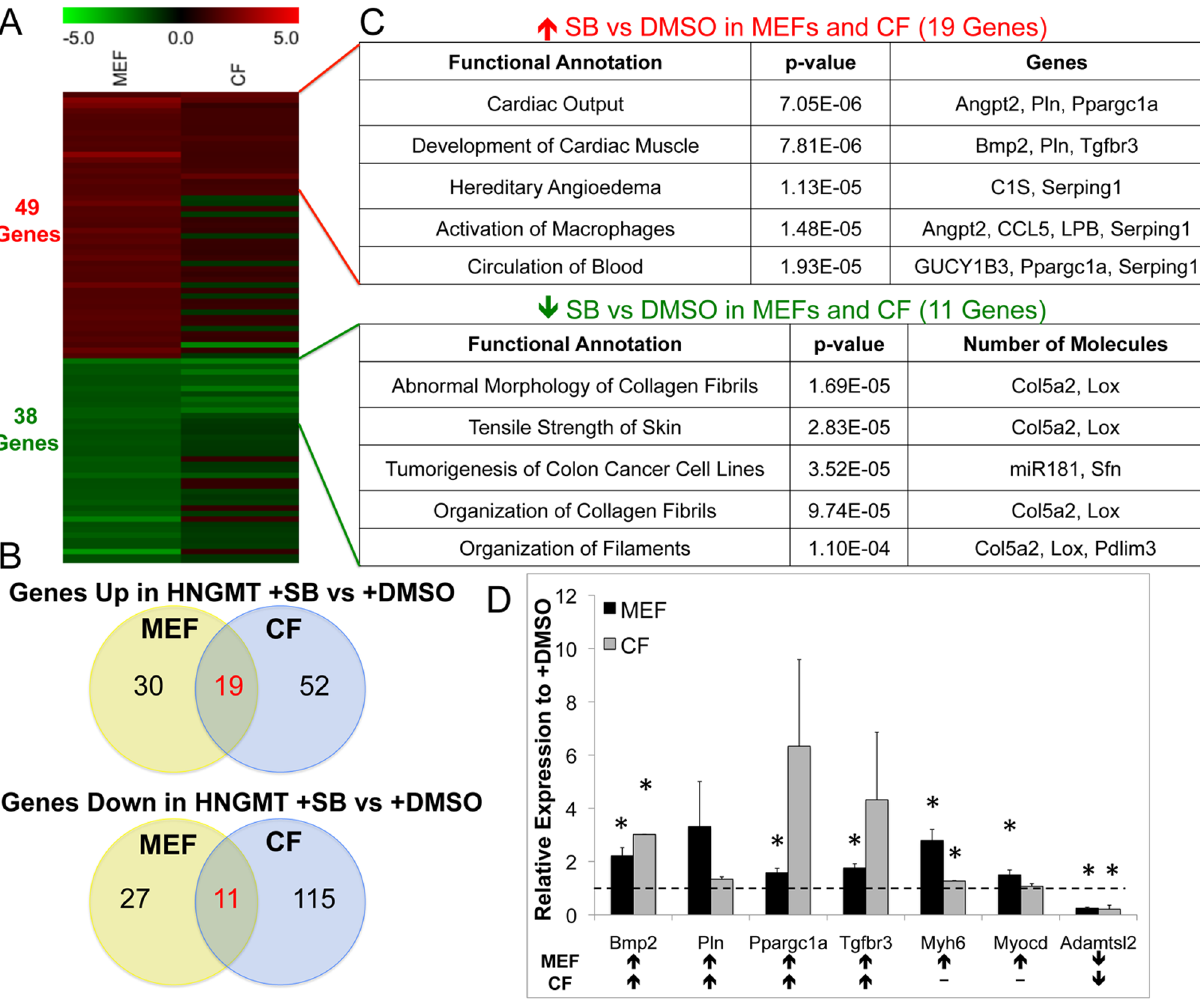
Figure 5. Evaluation of gene expression changes in MEFs and CFs during conversion with and without SB. Heatmap depicting the 49 and 38 genes up-regulated and down-regulated, respecively exclusively in MEFs for HNGMT + SB versus HNGMT + DMSO as well as the expression of the same genes in CFs (A). Venn diagrams demonstrating the overlap of 19 genes up-regulated HNGMT + SB for both MEFs and CFs as well as the 11 genes down-regulated in HNGMT + SB for both MEFs and CFs (B). The top five groups by p-value from as identified by functional analysis of the 19 commonly up-regulated and 11 commonly down-regulated genes in both MEFs and CFs for HNGMT + SB treatment (C). Quantitative RT-PCR results for genes identified to be involved in development of cardiac muscle and up-regulated by both MEFs and CFs (Bmp2, Pln, Ppargc1a, and Tgfbr3), or MEFs (Myh6 and Myocd), or down-regulated in both MEFs and CFs (Adamtsl2) (D). * indicates p , 0.05 compared to the HNGMT + DMSO control for that gene and cell type by Students